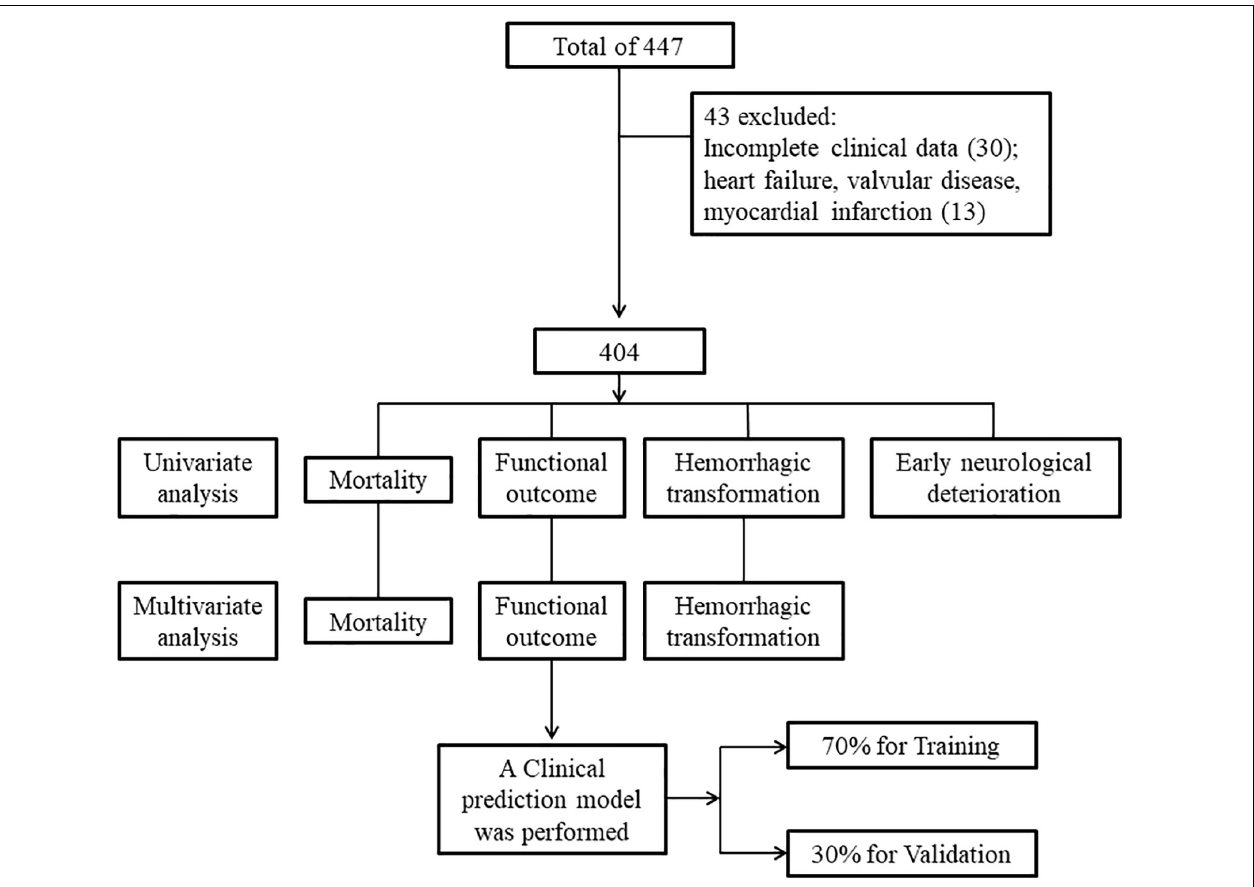
FIGURE 1 | Flowchart of patient selection. Four hundred and four patients were finally included in the study after exclusion. Univariate analysis was performed regarding mortality, functional outcome, hemorrhagic transformation, and early neurologic deterioration as outcome. Multivariate analysis was performed regarding mortality, functional outcome, and hemorrhagic transformation as outcome. A clinical prediction model was then performed with 70% patients as training group and 30% as validation group, regarding functional outcome as the